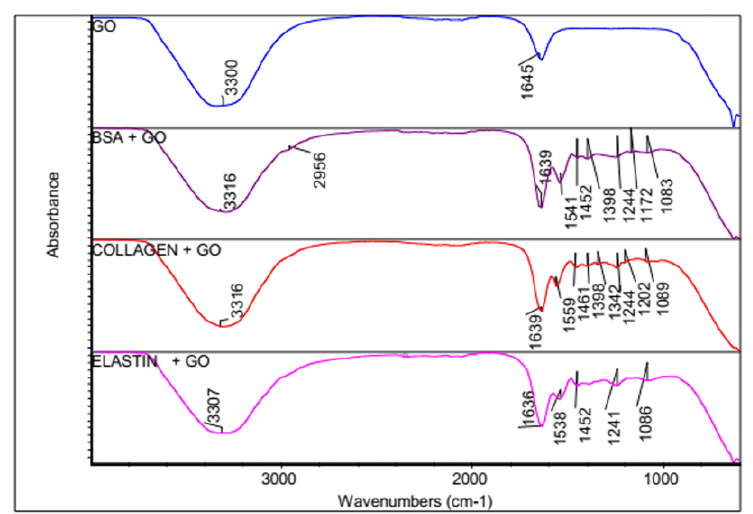
Figure 2. FTIR spectrum for GO, GO-BSA, GO-collagen and GO-elastin matrix.